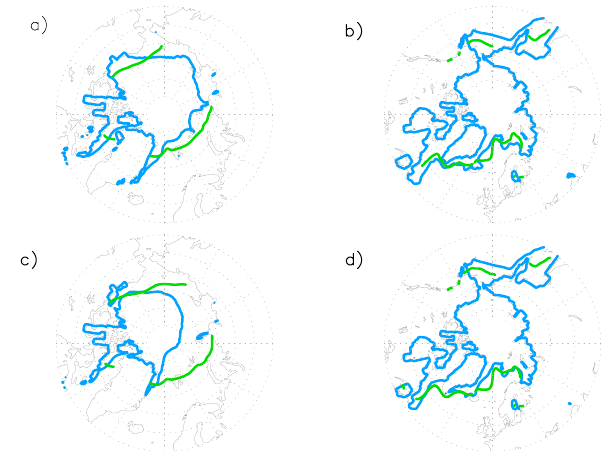
Fig. 10. Sea-ice edge (15% sea-ice concentration limit) location in the HadGEM2-ES (blue line) and the MIROC-ESM (green line). The upper panels show the (a) minimum and (b) maximum sea- ice limit in the pre-industrial climate. The lower panels show the (c) minimum and (d) maximum sea-ice limit in the mid-Holocene climate. The change in the sea-ice edge location from MH to PI is larger for the minimum ice extent, especially for the HadGEM2-ES model.